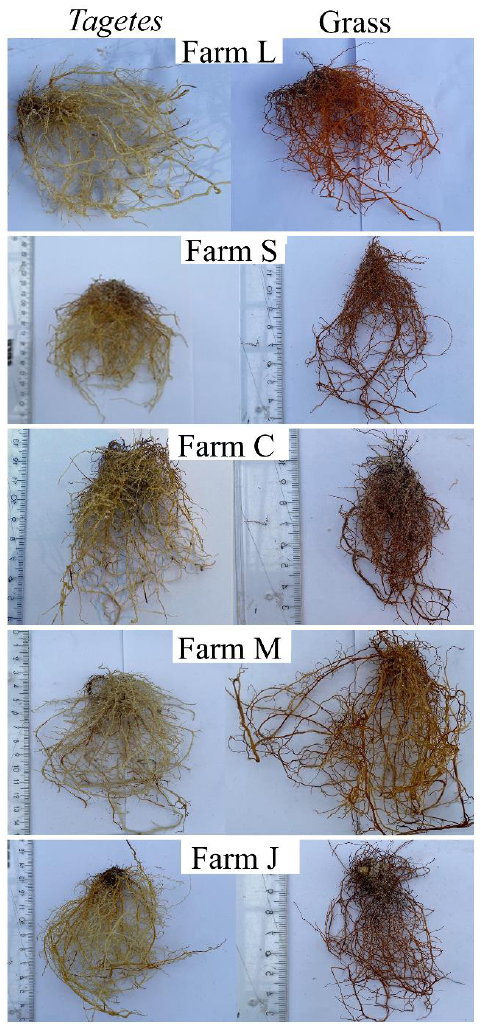
Figure 2. Discoloration and stunting of apple roots in the biotest of nematode fractions extracted from soils of plots in tree nurseries (farms L, S, C) and apple orchards (farms M and J), which were pre-cultured with either Tagetes or grass before planting of apple rootstocks.